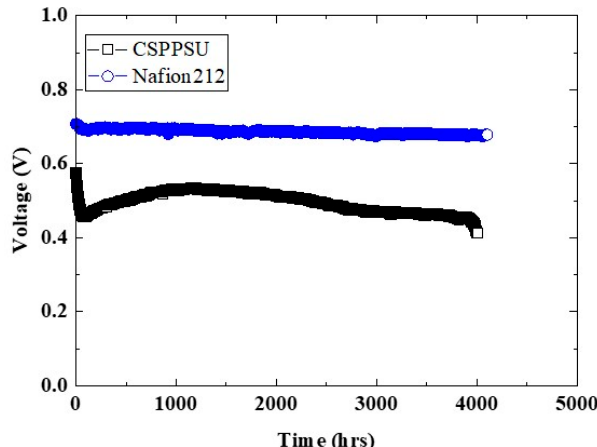
Figure 10. Durability of CSPPSU and Nafion212 membranes at 80 °C, 100% RH, and 1 A.